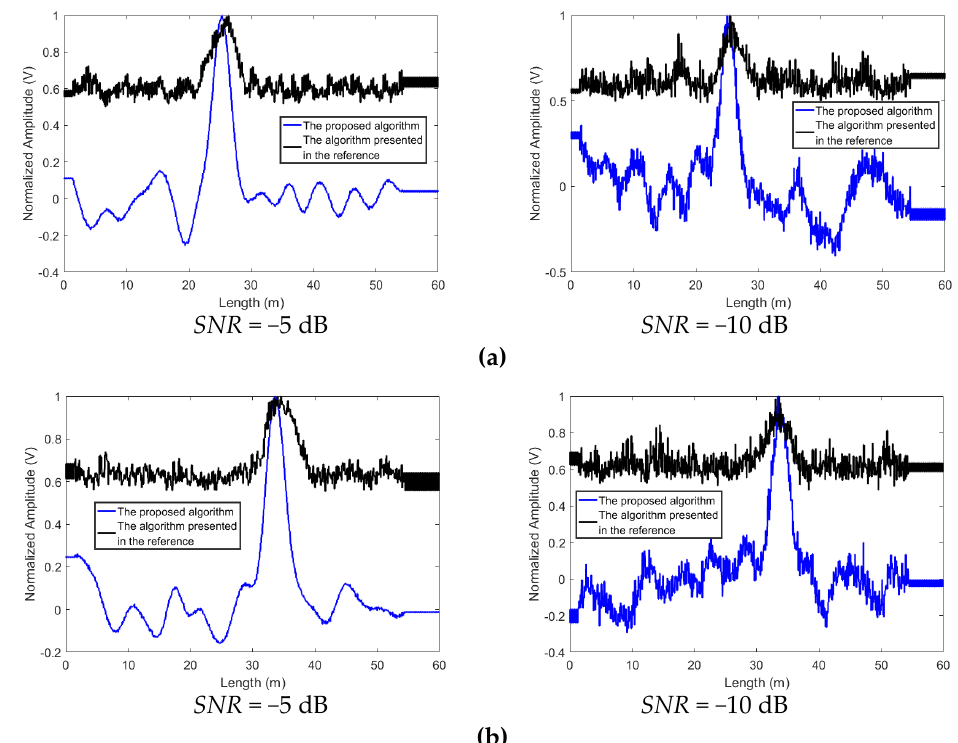
Figure 9. The localization results obtained by using the proposed algorithm and the method (the parameter p = 1) presented in [80] at various SNR s, ( a ) L1 and ( b ) L2.